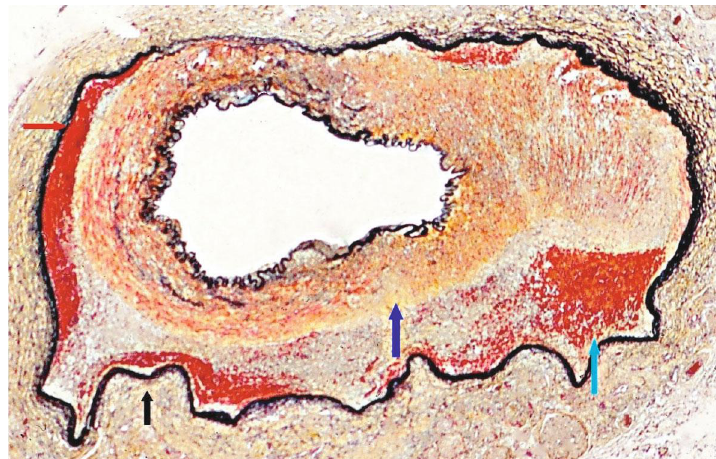
Figure 20: Segmental arterial mediolysis, reparative phase. The cyan arrow points to a hematoma formed in the mature granulation tissue fi lling and expanding the adventitial medial tear. Adjacent scattered red cells are gathered at the external elastica (black arrow). The red arrow points to a large dissecting hematoma bordered by an intact external elastica. Part of this dissections is evident in the superior view of the artery, and a beginning dissection appears to be generating near the black arrow. The blue arrow points to foci of outer medial fi brosis (yellow stain). Movat stain × 25.